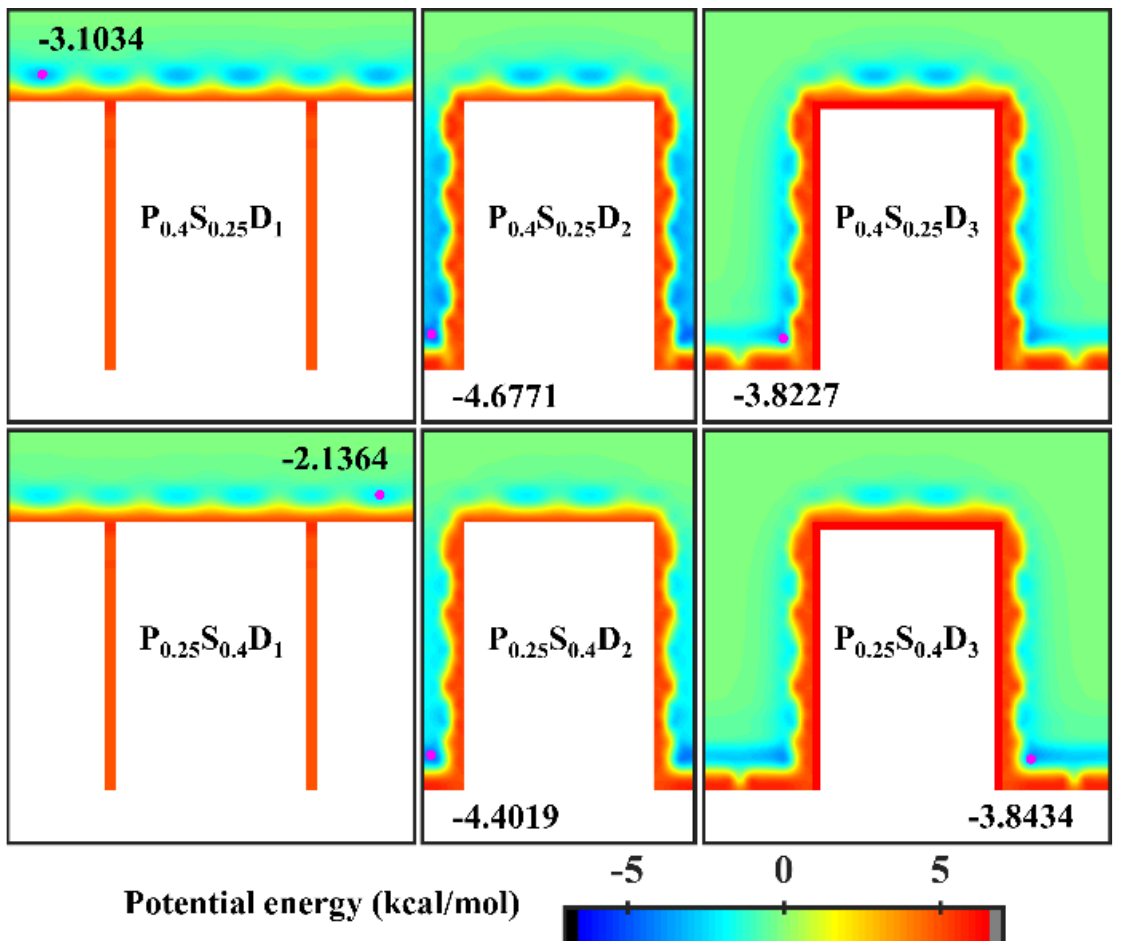
Figure 8. Equipotential curves of potential energy between water molecule and the nanopillar surfaces with hybrid wettability. The minimum values of the potential energy are given in the figure and their positions are marked with a pink dot.